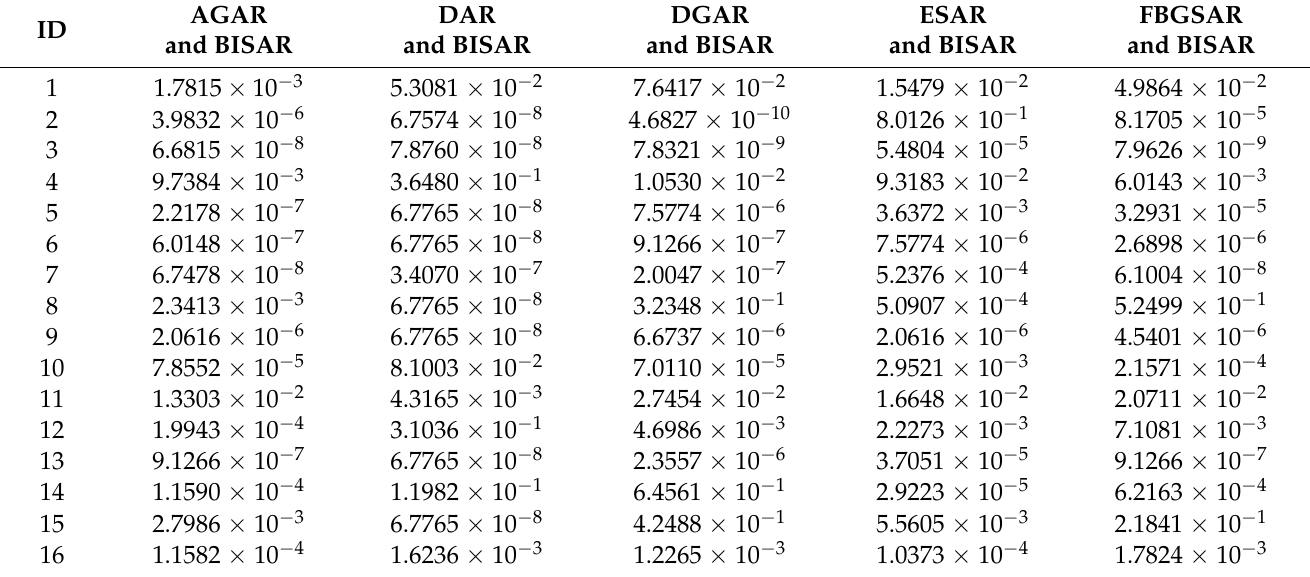
Table 5. p -values for comparing stabilities (raw data).